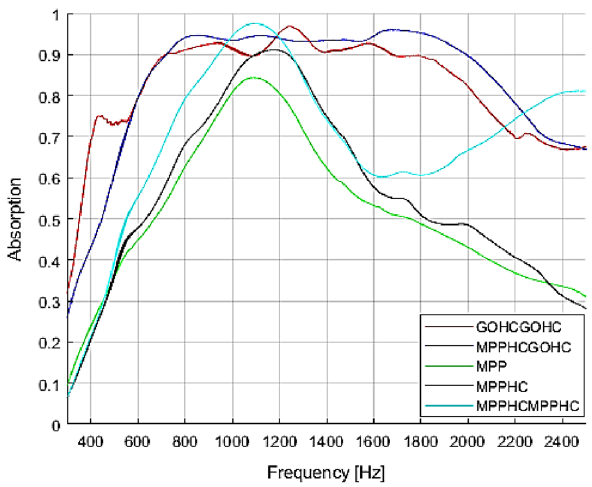
Figure 4. Comparison between the proposed metamaterial structure GOHCGOHC and MPPHCGPHC, the MPP absorber, the MPPHC structure and MPPHCMPPHC structure. All the tested structure present the same global thickness (50mmm) and the same geometrical parameter (MPP thickness 1.5 mm, perforation ratio 6% GO foil thickness 30